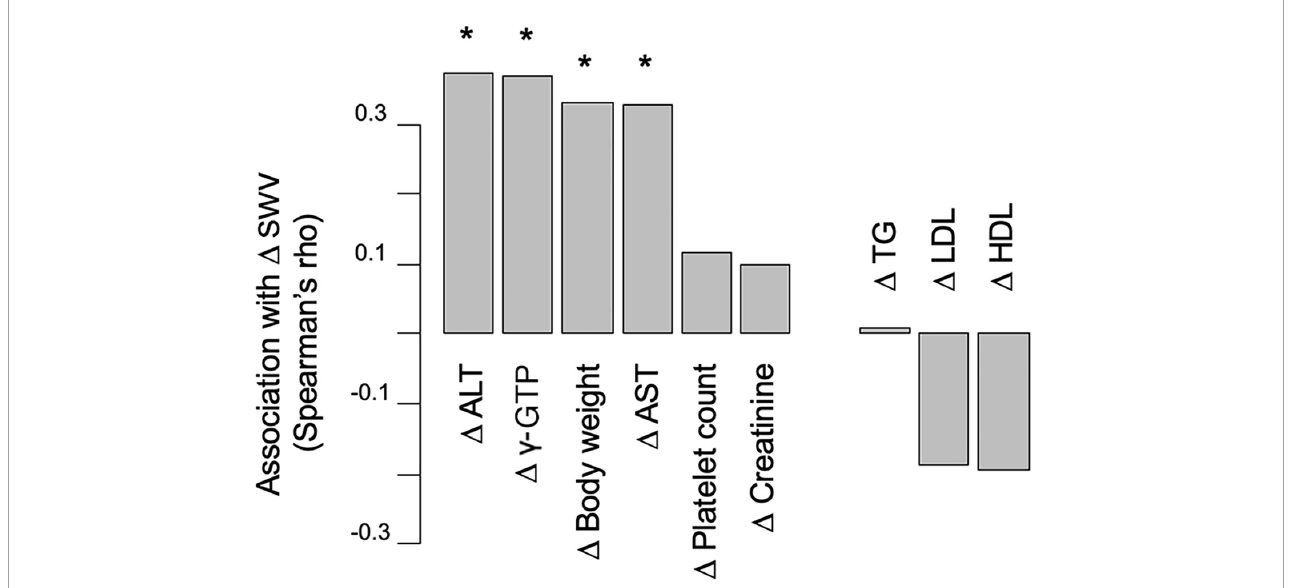
FIGURE3 The association between change in SWV and changes in laboratory variables. SWV, shear wave velocity; AST, aspartate aminotransferase; ALT, alanine aminotransferase; γ -GTP, γ -glutamyl transpeptidase; TG, triglyceride; HDL-C, high-density lipoprotein cholesterol. * P <